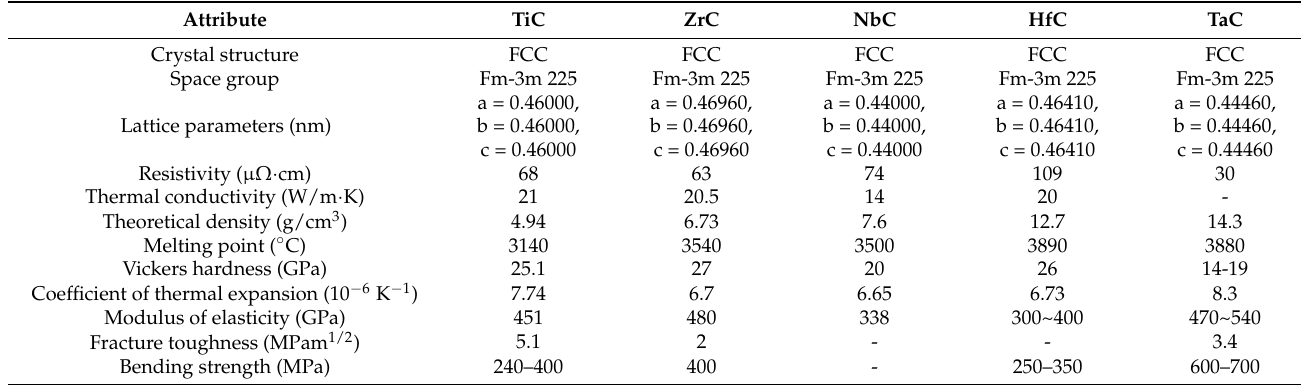
Table 1. Some properties parameters of carbide ceramics [36–40].